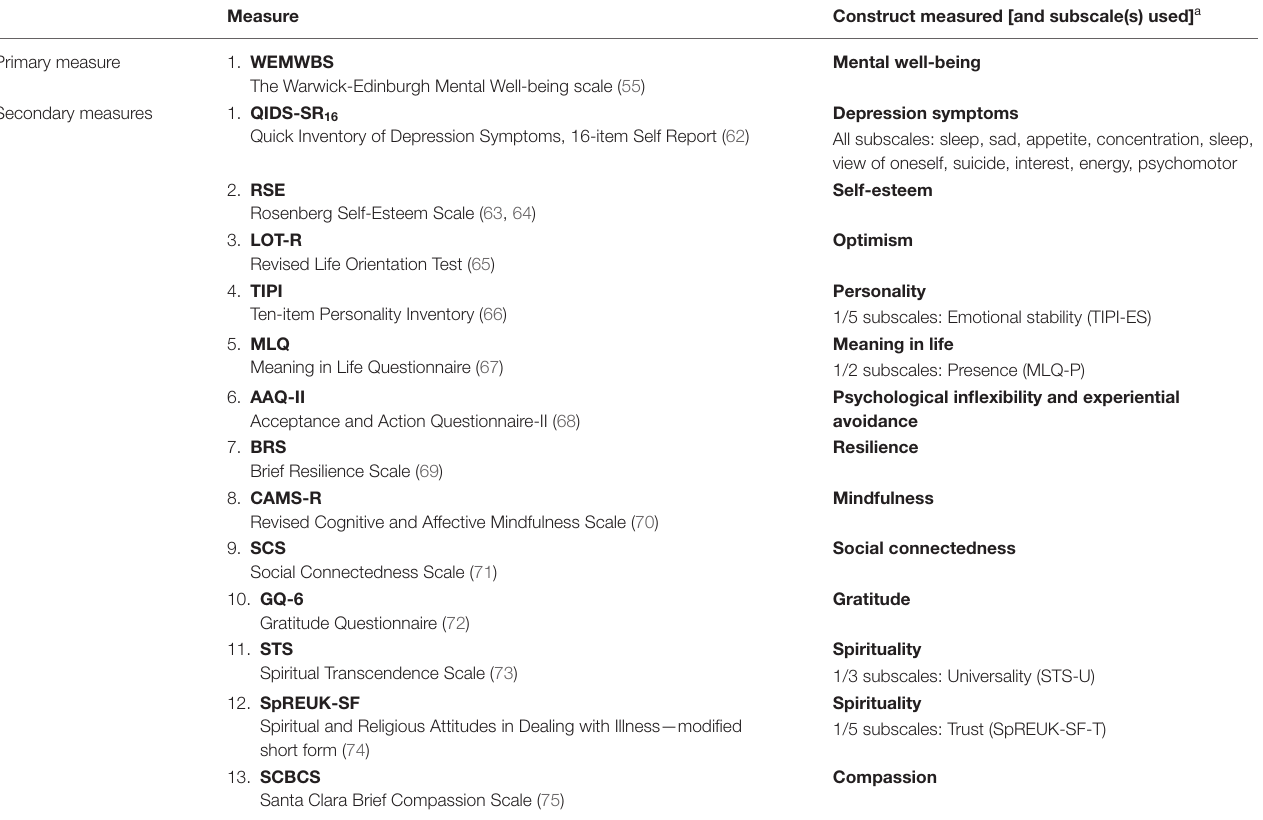
TABLE 1 | Included outcome measures for the main